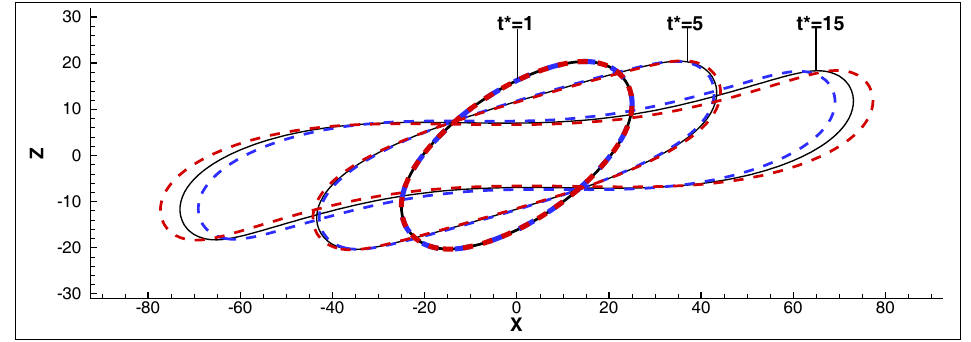
Figure 8. Transient droplet shapes, in the x - z middle plane, in systems N–N / λ = 0.3 (solid-black), PL–N / n d = 1.125 (dashed-blue), and PL–N / n d ≈ 1.2747 (dashed-red lines), at time instants t ∗ = 1,5,15.